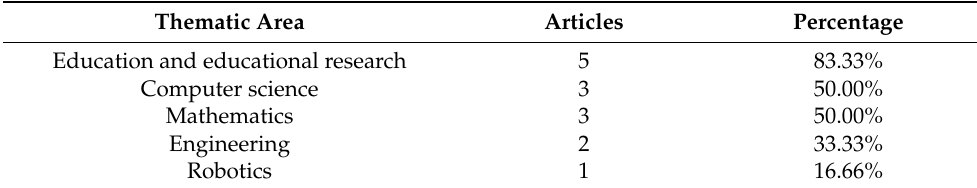
Table 3. Thematic areas of articles indexed in WOS. Figure 3. Percentage graph of the countries to which the affiliating institutions belong. Source: own production.